Question: Sum up the contents of this chart in one sentence.
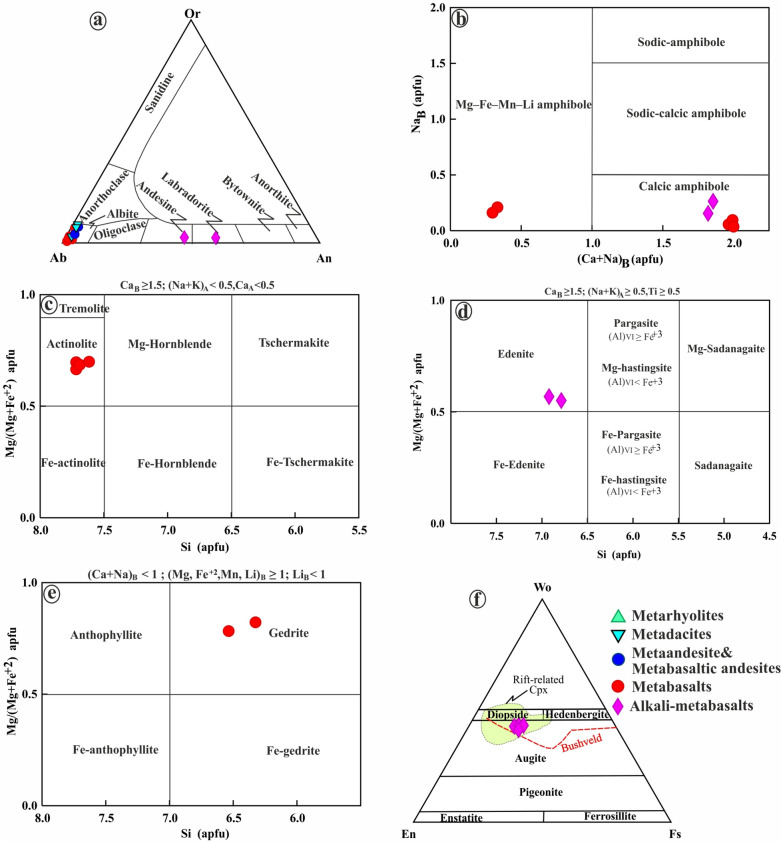
Answer: Mineral chemistry of plagioclase and amphibole minerals from the WRAM. ( a ) Ab‒An‒Or ternary classification diagram of plagioclase 83 , ( b ) (Ca + Na) B vs Na B classification diagram of amphibole types 84 , ( c ), ( d ) Si vs Mg/(Mg + Fe 2+ ) classification diagrams of calcic amphiboles, respectively 84 , ( e ) Si vs. Mg/(Mg + Fe 2+ ) classification diagrams of magnesian amphiboles 84 , ( f ) Enstatite (En)-Ferrosilite (Fs)-Wollastonite(Wo) ternary diagram of clinopyroxene 85 . The rift-related Cpx polygon is after Muravyeva, et al. 86 , Li, et al. 87 , and Zhu, et al. 88 ; while the Bushveld line is after Atkins 89 . This figure is created by the Igpet 2010 software ( https://www.rockware.com/product/igpet/ ).